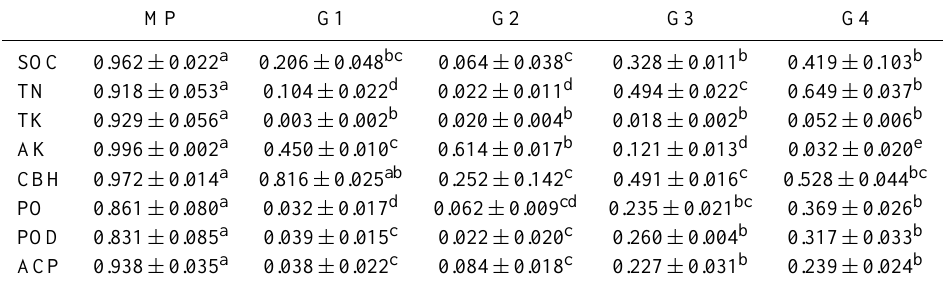
Table 1. Soil quality indicator scores (mean ± standard error) for soil samples taken from the Pinus and Eucalyptus plantations.